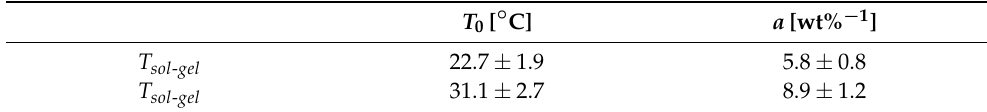
Table 2. Values of the regression parameters of the linear fits in Figure